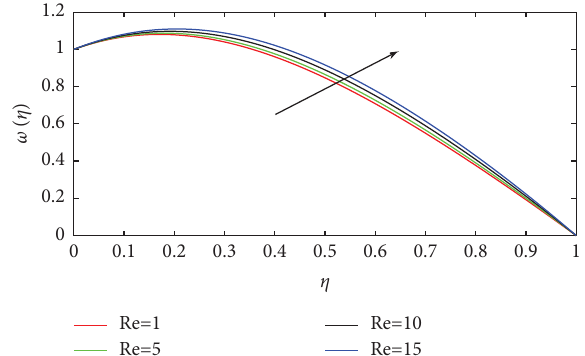
Figure 6: Velocity profles for the diferent values of Ha.